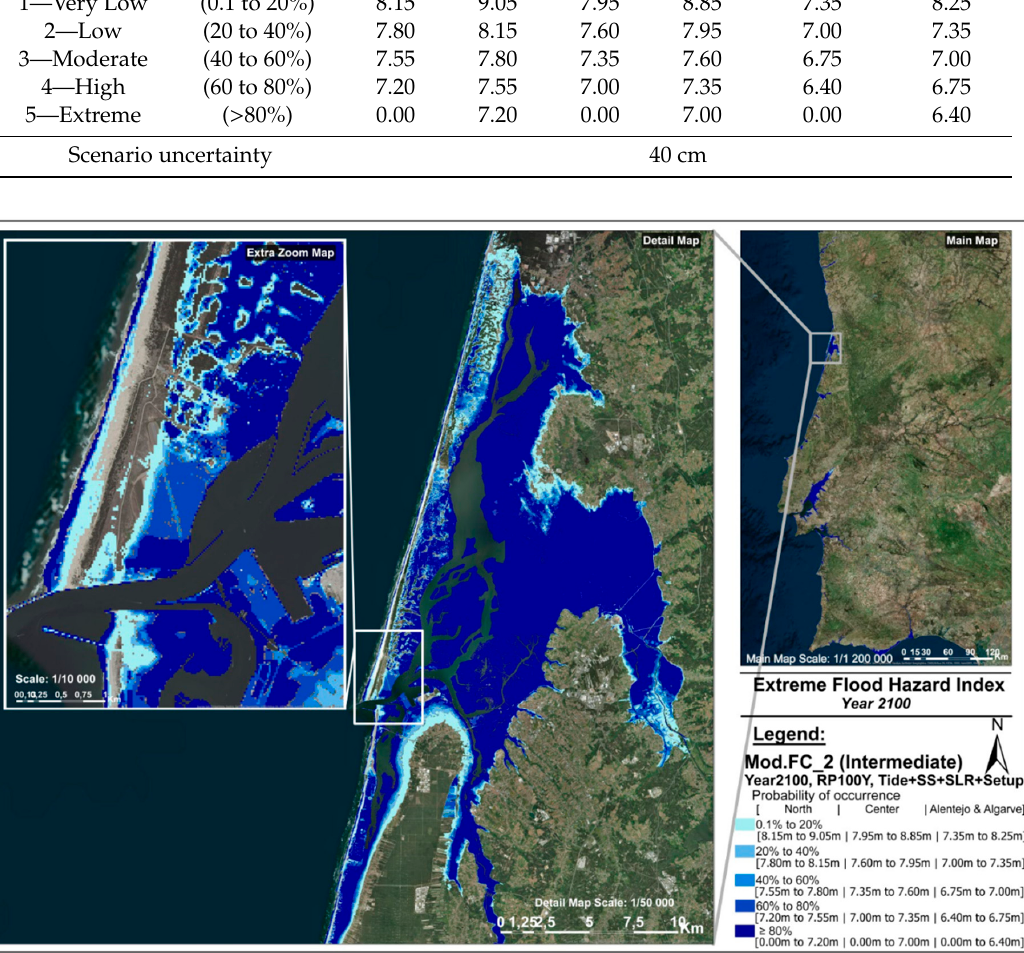
Figure 10. Portuguese coastal flooding extreme scenario with the influence of wave and wind setup, for 2100 SLR and 100-yr RP, within a zoom image of the Aveiro inland lagoon (Ria de Aveiro). Table 9. Intervals for each EFHI level and respective probability for the SLR 2100 scenario with 100- year RP storm surge and the additional setup component for each geographic zone, relative to the central reference flooding elevation level (the Ref value corresponds to the EFL central estimation).